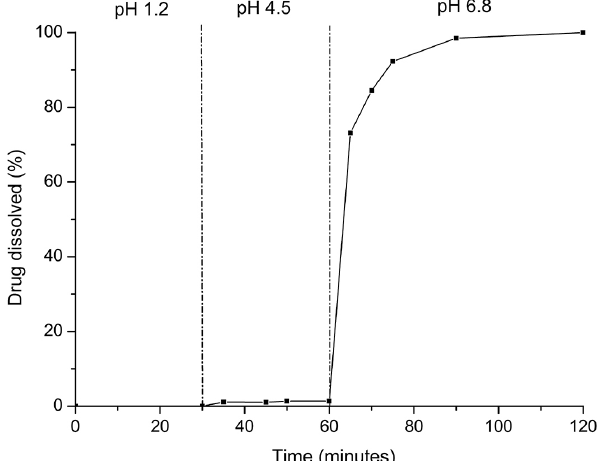
extended-release formulation using apparatus 3 under different pH conditions (1.2, 4.5, 6.8, 7.2 and 7.5).